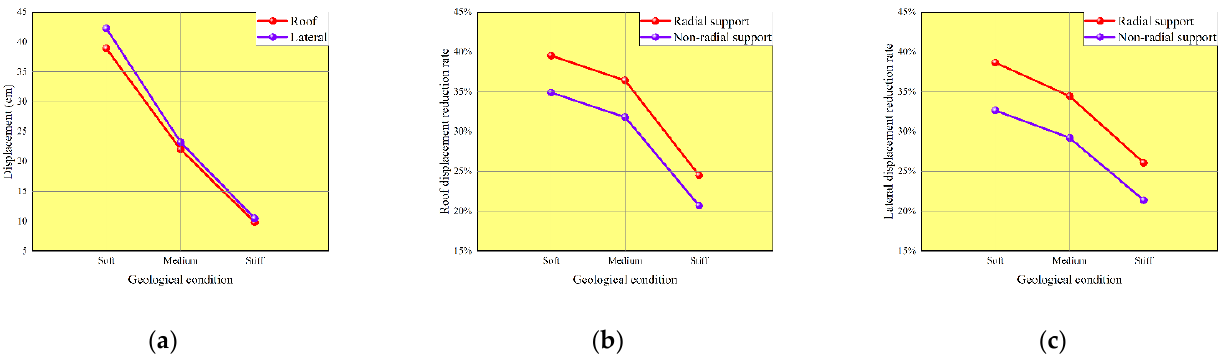
Figure 18. Maximum stresses and variations of the support face under the two support schemes: ( a ) unsupported stress, ( b ) vertical stress variations, and ( c ) horizontal stress variations.